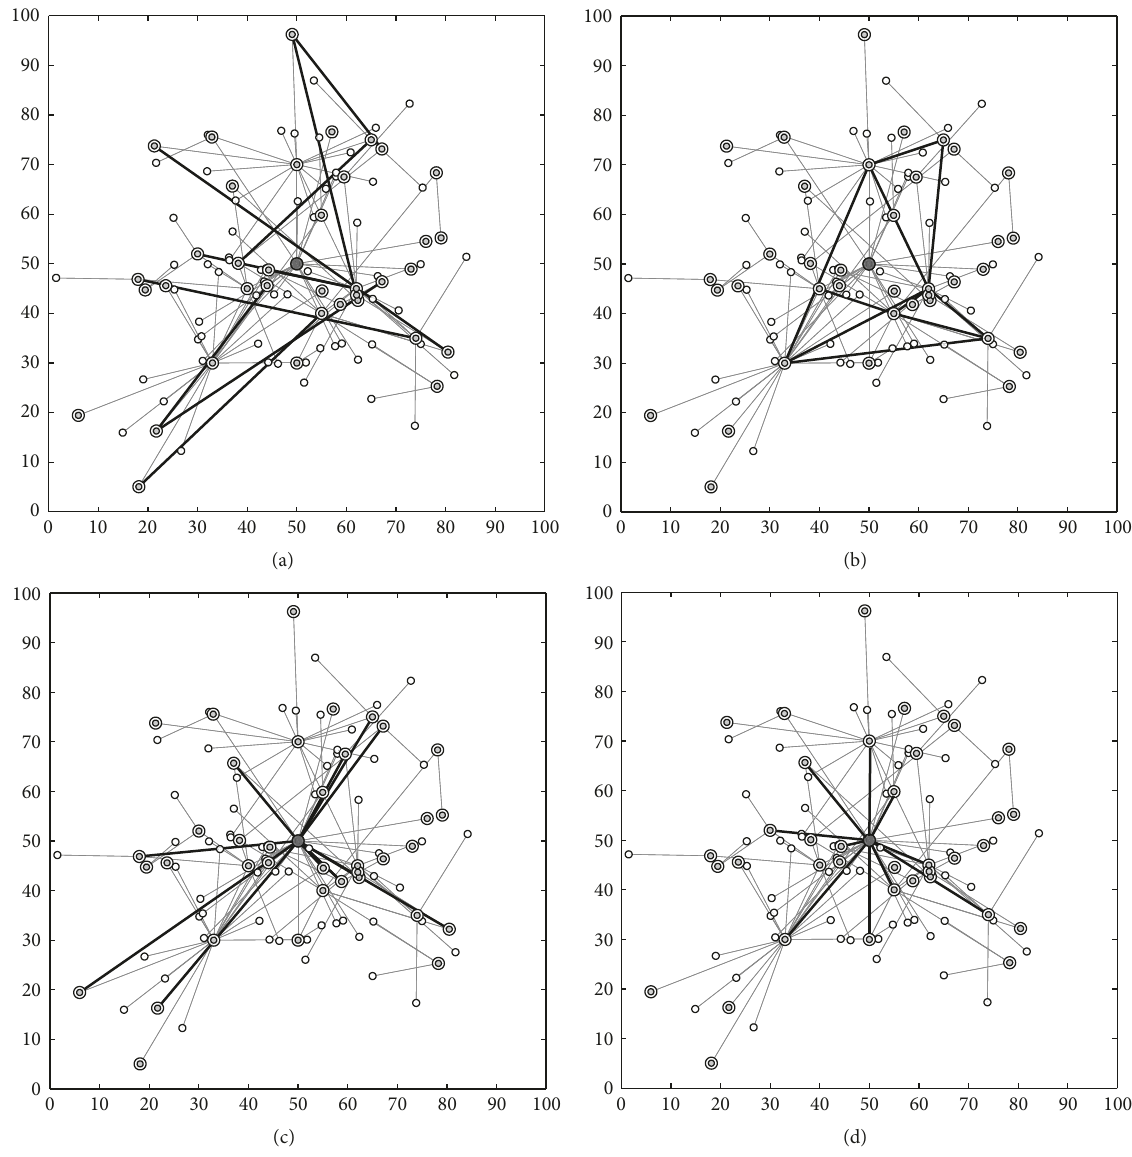
Figure2:Scale-freeWSNstopologyunderdifferentaddingschemesofshortcuts.(a)SchemeRC.(b)SchemeSC.(c)SchemeRCS.(d)Scheme